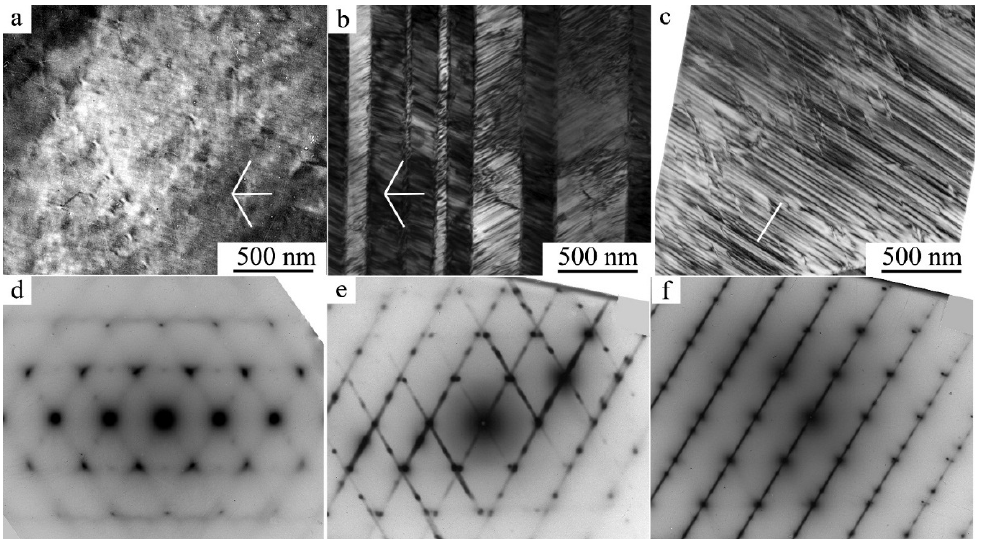
Figure 12. ( a ) Dark-field and ( b , c ) bright-field TEM images of the deformation-induced tweed contrast in the ( a ) β 1 -austenite, (b) twinned γ 1 ′ martensite, and ( c ) β 1 ′ martensite of the alloy Cu–13.5Al–3.5Ni and ( d – f ) their corresponding SAED patterns, with zone axis close to [111]; D0 3 . Observations ( a , d ) at 450 K, and ( b , c , e , f )–at RT [62].